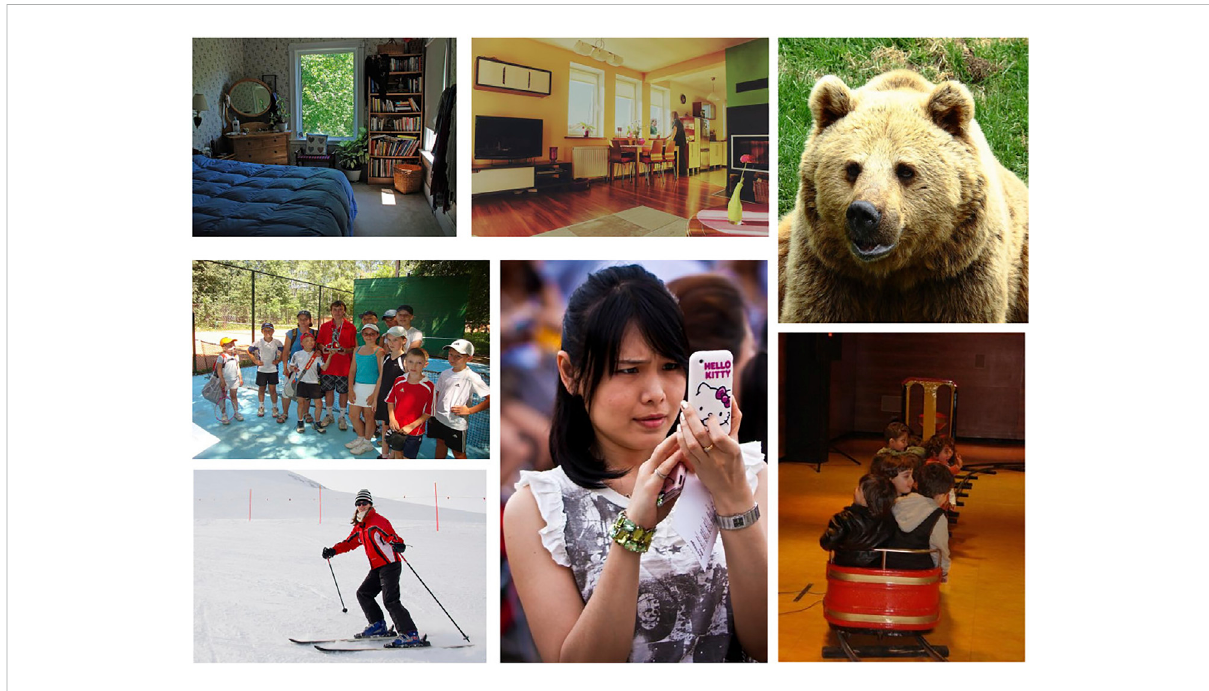
FIGURE 3 Sample images taken from COCO-Stuff dataset (Caesar et al.,